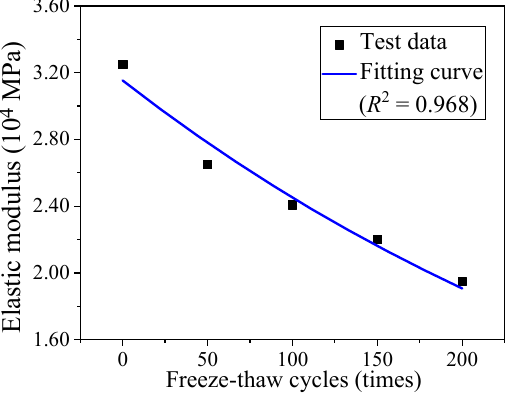
Figure 7. Fitting results for the elastic modulus of concrete considering the combined action of Freeze–thaw and chloride-induced